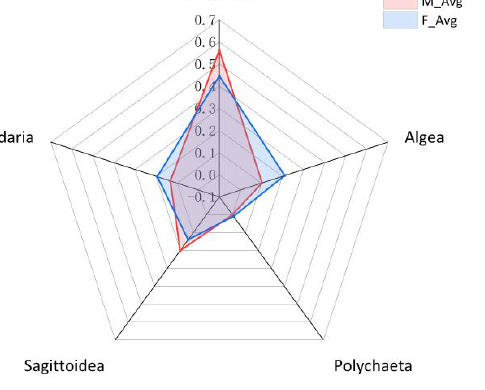
Figure 3. Distribution of prey species of male and female samples. M_Avg and F_Avg represent the mean proportion of contigs quantity of prey of male and female M. caml .